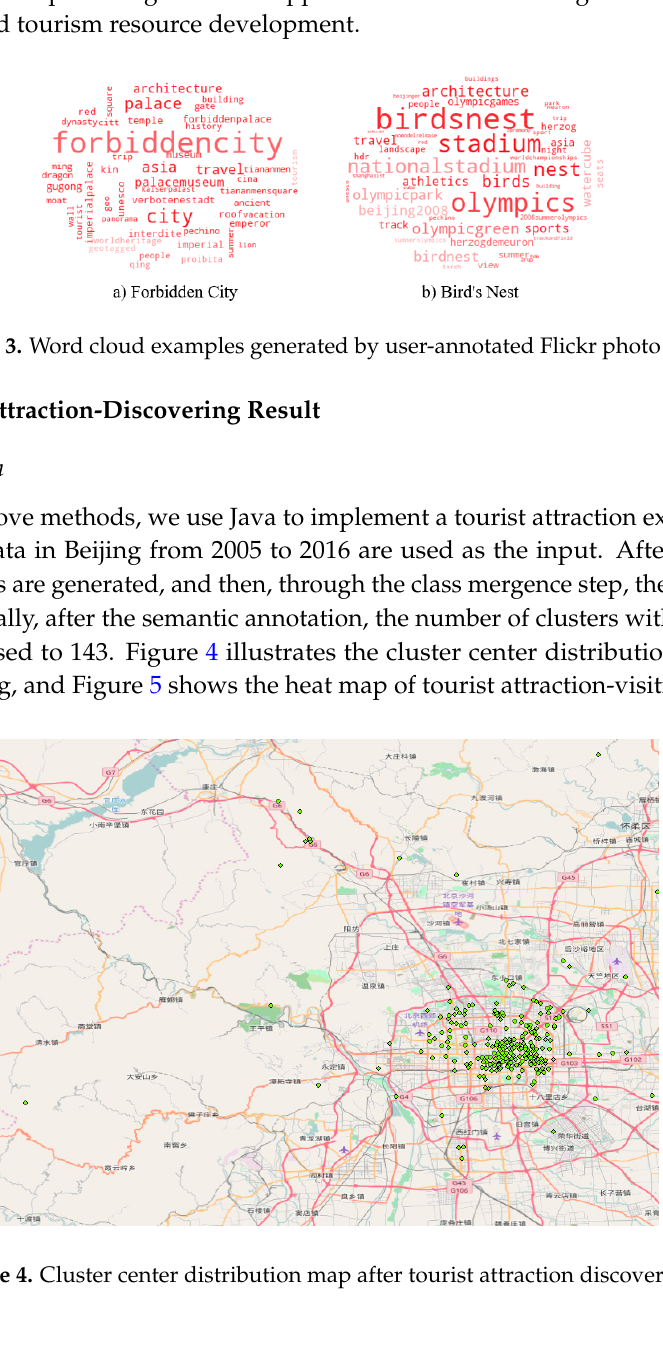
Figure 4. Cluster center distribution map after tourist attraction discovering.